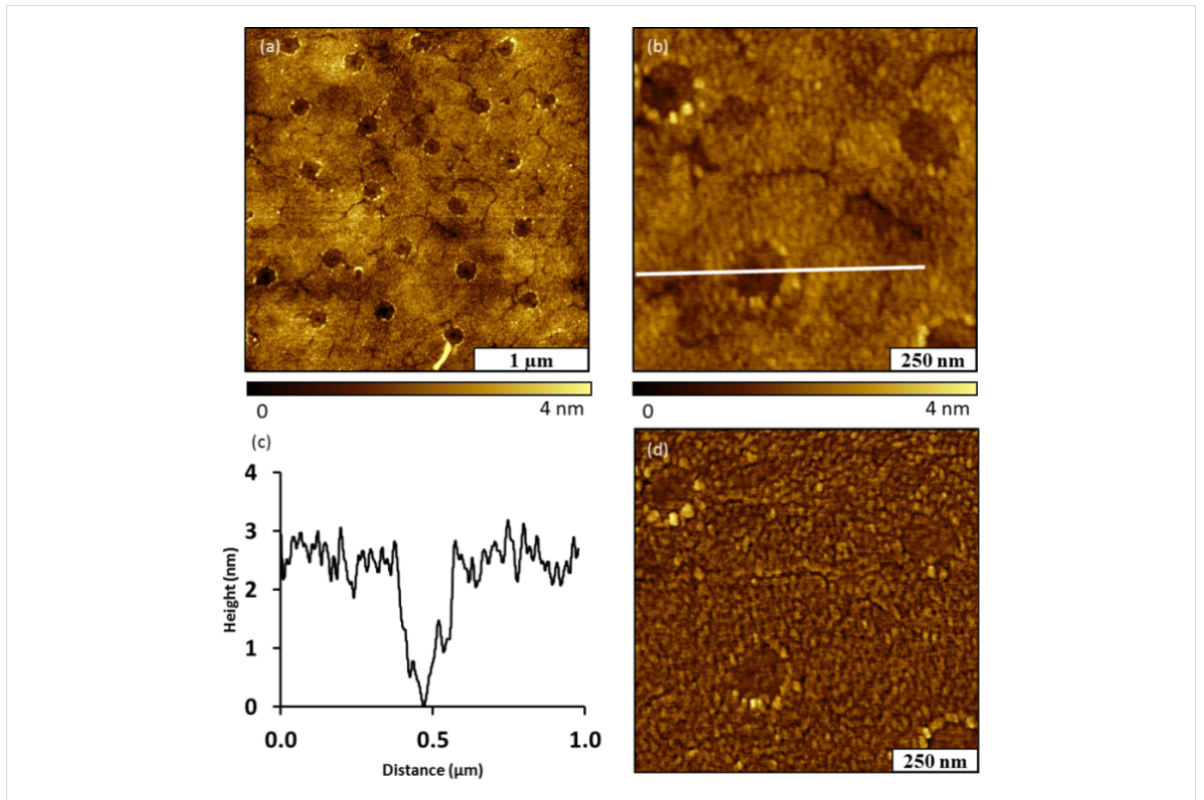
Figure 5: Au–NHBoc film after storage in ambient conditions for six months. (a) Topography image; (b) zoom-in view; (c) cursor profile for the line in (b); (d) corresponding phase image of (b).